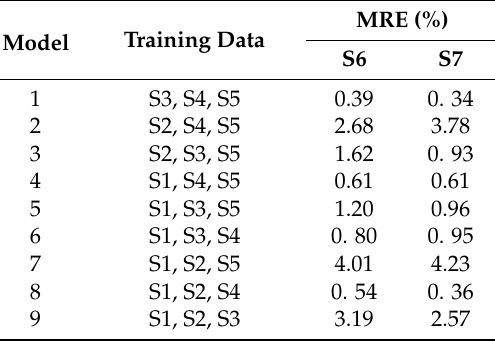
Table 11. The predicted MREs of S6 and S7 based on different training